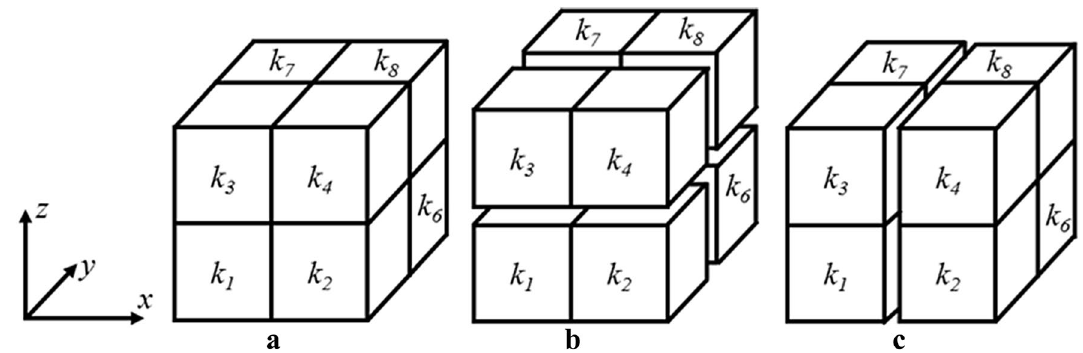
Fig. 2 Schematic illustration of the two-dimensional renormalization blocks used in the approximation of the three-dimensional renormalization (Karim and Krabbenhoft 2010)